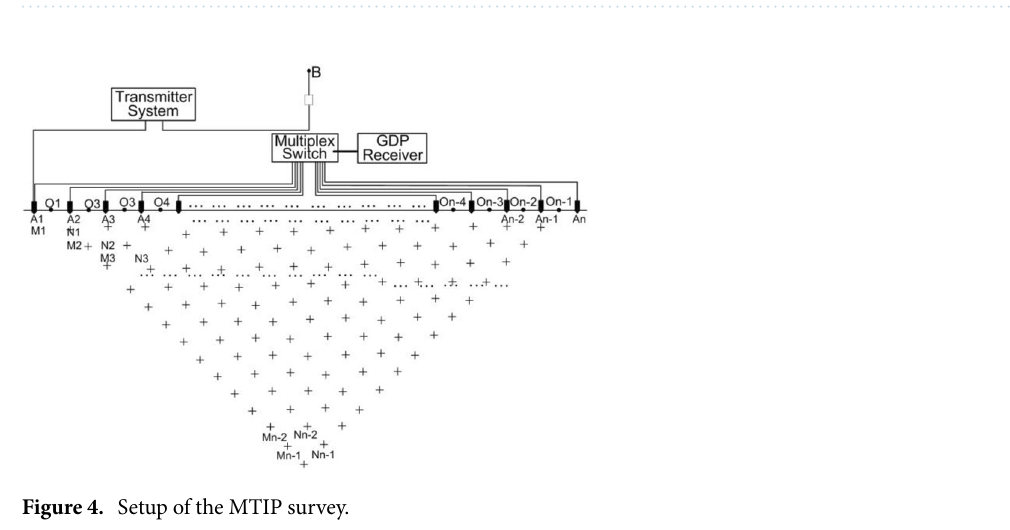
Figure 3. Geological map of the research area; positions of MTIP survey lines; with MTIP sounding profile (blue). Map created in Surfer 14.0.599 of Golden Software, LLC (https:// www. golde nsoft ware. com/ produ cts/ surfer).